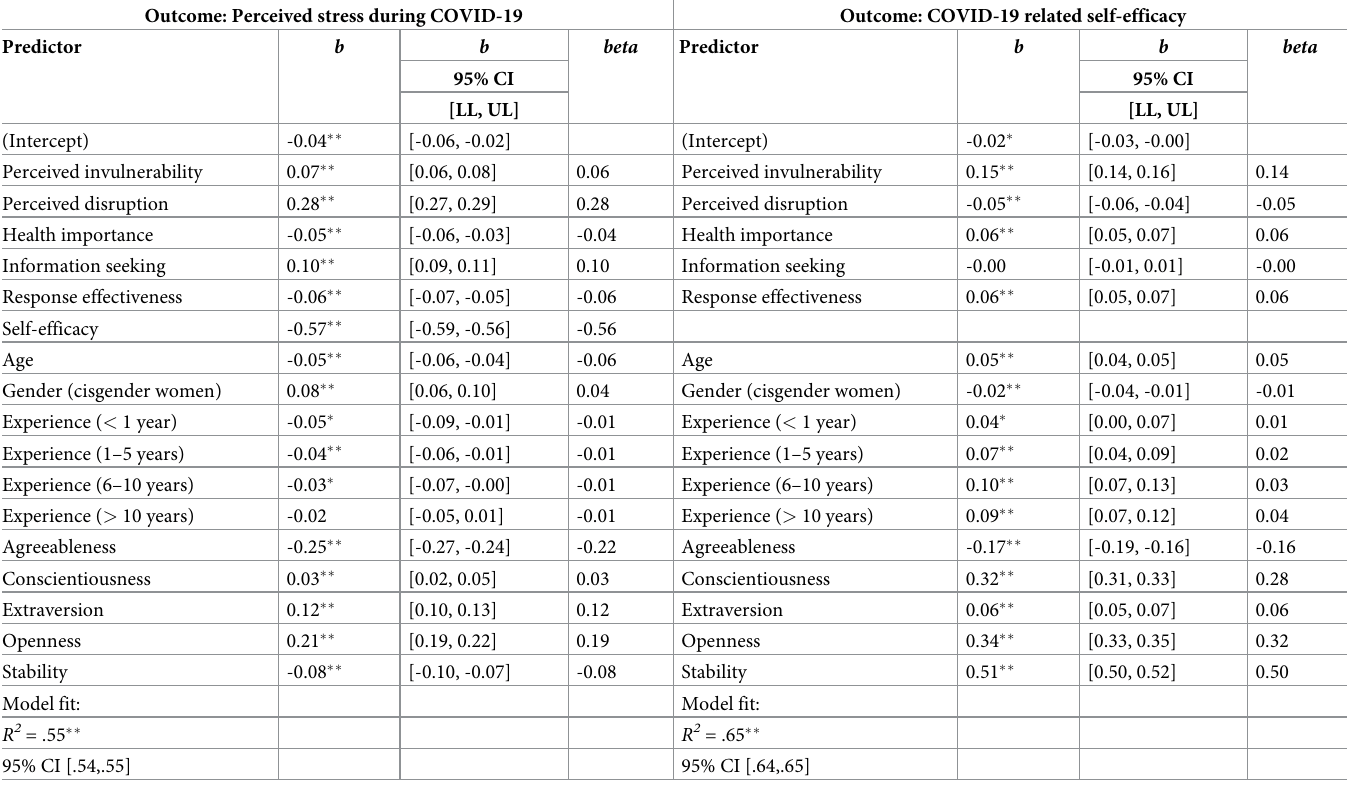
Table 3. Regression